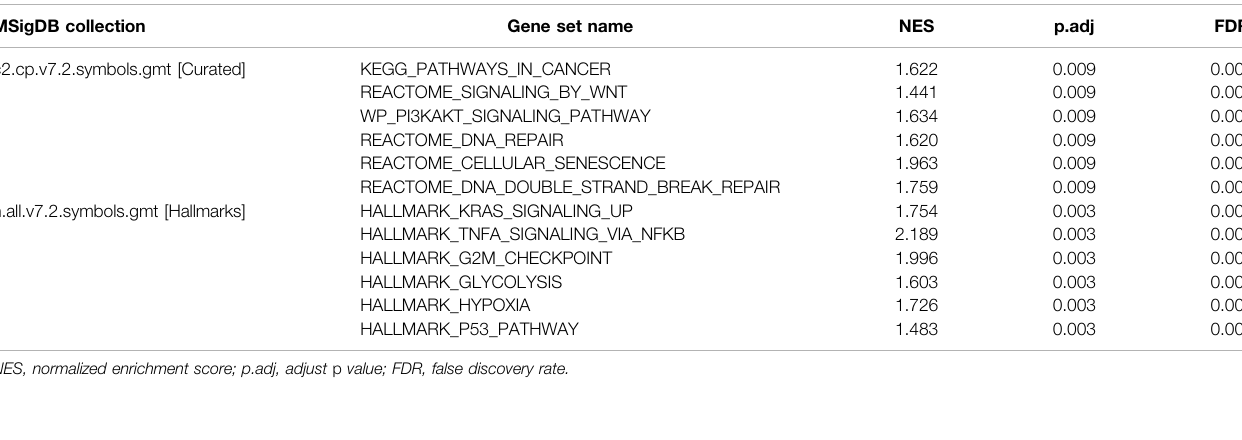
Frontiers in Molecular Biosciences |